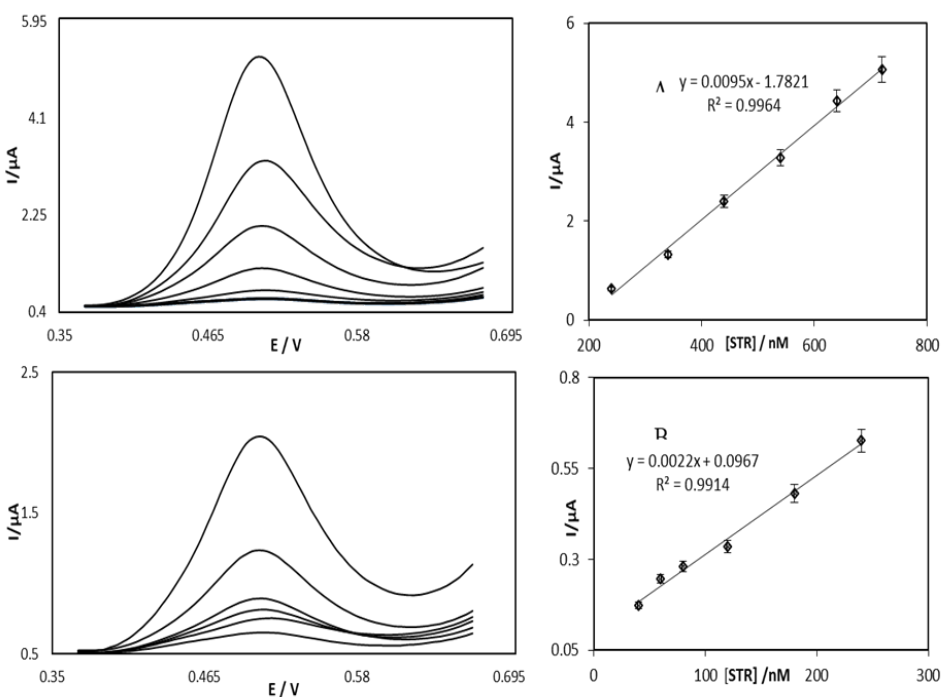
Figure 8. Di ff erential pulse voltammograms of the GO / OB / SNP / SPE in 0.1 M phosphate bu ff er solution pH = 7.0 containing di ff erent concentrations of STR (from 0.36 to 0.67 V and peak potential of 0.54 V). The voltammograms correspond to STR. Inset A shows the plots of the electrocatalytic peak current as a function of STR concentration in the range of 0.4 to 240.0 nM and inset B is the peak current as a function of STR concentration in the range of 240.0 to 720.0 nM. Table 1. Comparison of the present method with other analytical methods.